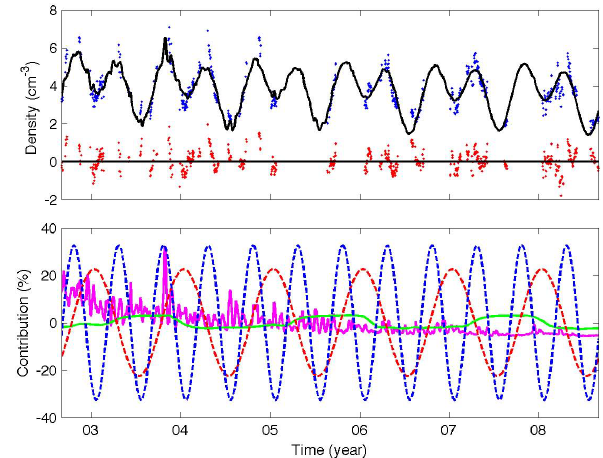
Fig. 9. An example of the O 3 number density fitting at 90km in 40 ◦ N–50 ◦ N. Time axis unit is day. In the upper panel GOMOS measurements are shown by the blue dots and the fit by the black line. The residual is shown by red dots. All three scaled by scaled by 10 8 cm − 3 . In the lower panel the identifications are: Annual ( a 1 and b 1 contributions): dashed red, Semi-annual ( a 2 and b 2 con- tributions): dashed blue, QBO 1 ( q 1 and q 2 contributions): solid green, solar ( s ): solid magenta. The components have been scaled by a constant coefficient and given in %. The constant term itself has not been